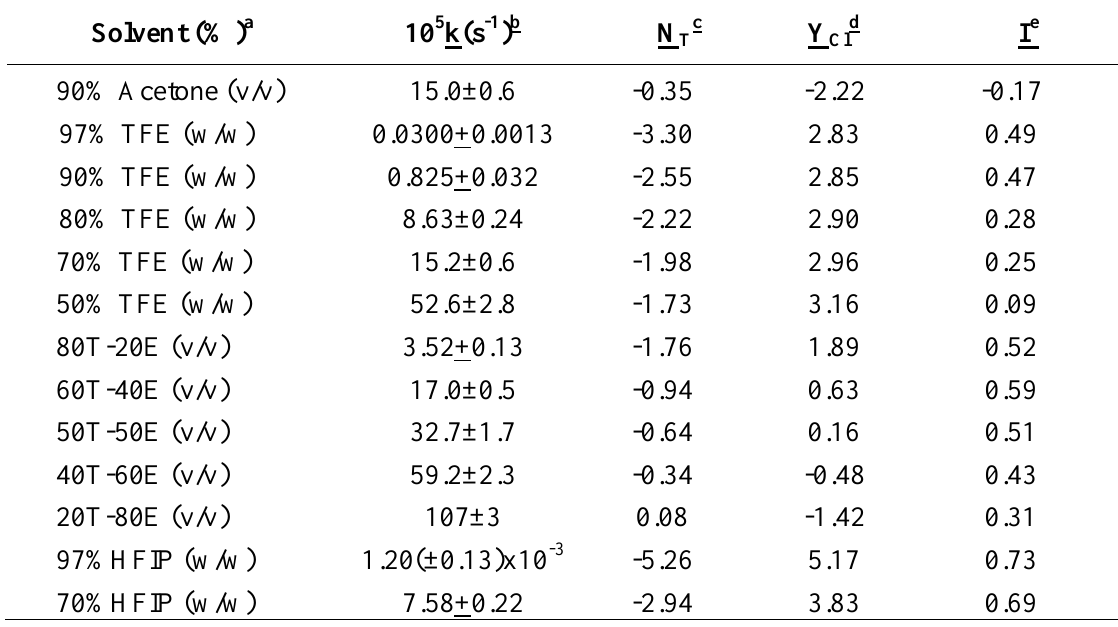
Table 1 . Specific rates of solvolysis (k) of p -methoxyphenyl chloroformate in several binary solvents at 25.0 ºC and the solvent nucleophilicity (N and aromatic ring parameter (I) values for the